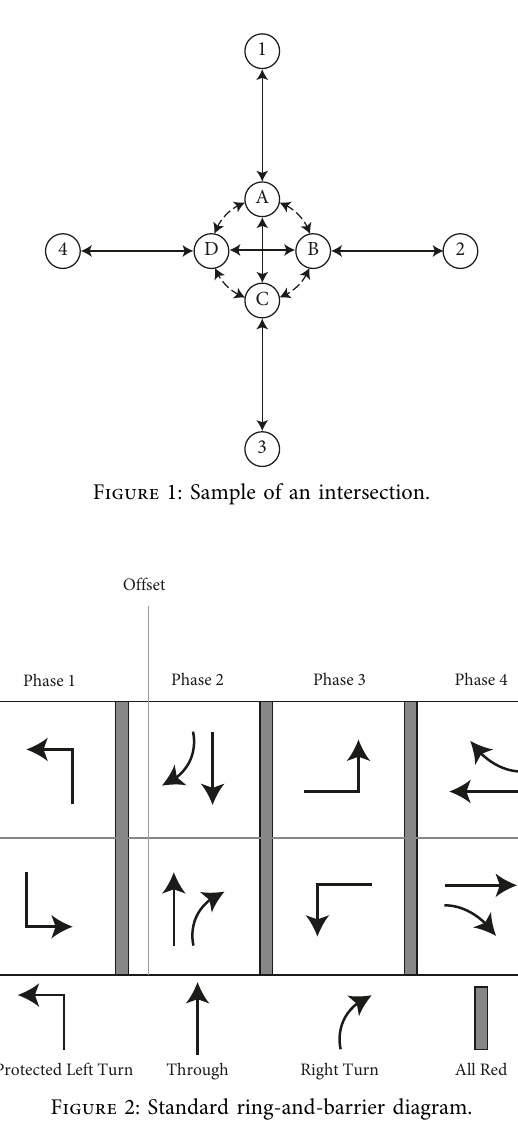
Figure 2: Standard ring-and-barrier